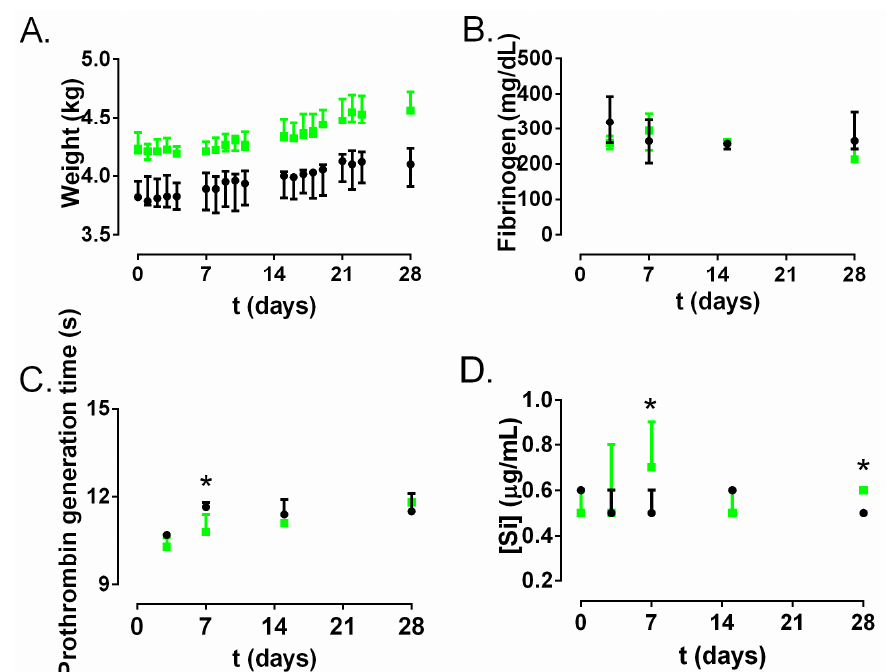
Figure 6. Hematological coagulation model results of control catheter group (black) and A50-coated catheter group (green) over time: weight ( A ); fibrinogen ( B ); prothrombin generation time ( C ); and silica concentration in serum ( D ). *: p -value < 0.05 for Wilcoxon test between control catheter group and A50-coated catheter group.